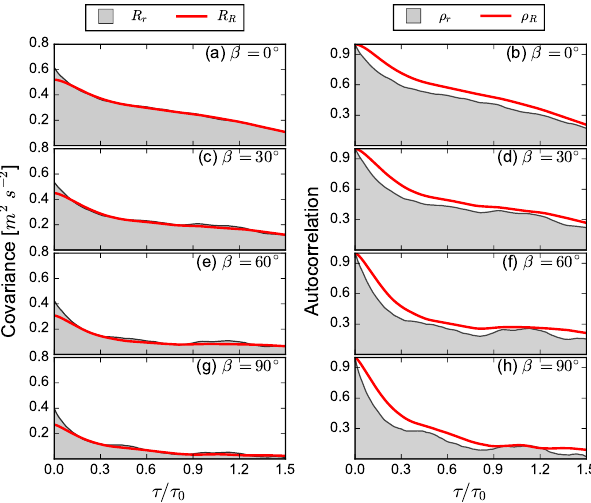
Figure 3. Covariance ( R r and R R on the left) and autocorrelation functions ( ρ r and ρ R on the right) of the point radial velocity ( v r ) and averaged radial velocity ( v R ) derived from statistically sim- ulated time series using TurbSim with the SMOOTH model and the default parameter values. Covariance and autocorrelation func- tions are presented for four different LOS orientations here as indi- cated by the angle of LOS relative to the mean wind direction ( β ). The time lag ( τ ) is normalized by τ 0 , which is the first time when ρ r = 1 /e at β = 0. A fixed elevation angle of 10 ◦ is used.